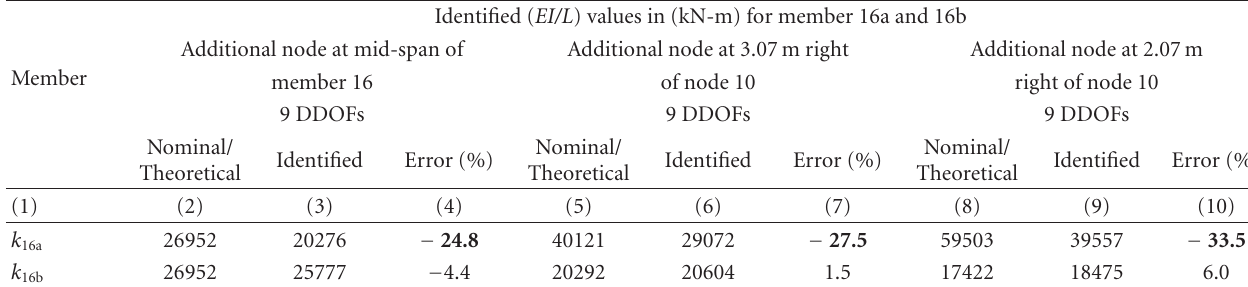
Table 5: Sti ff ness parameter ( EI/L ) identification for defect 3 using Stage 1 of